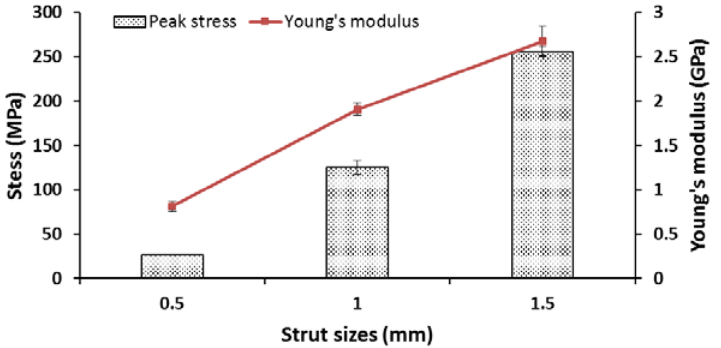
Figure 20. Compressive peak stress based on the total cross-sectional area of the samples (modified scan strategy) (see also Table 4).